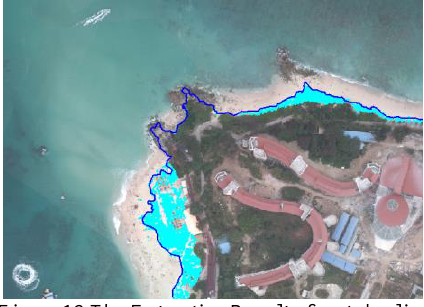
Figure 12 The Extraction Result of wet-dry line